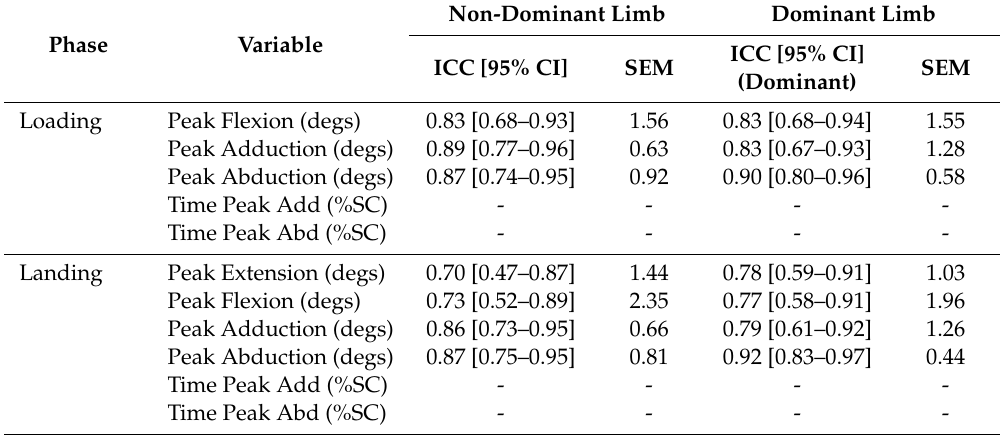
Table 1. Reliability measures.